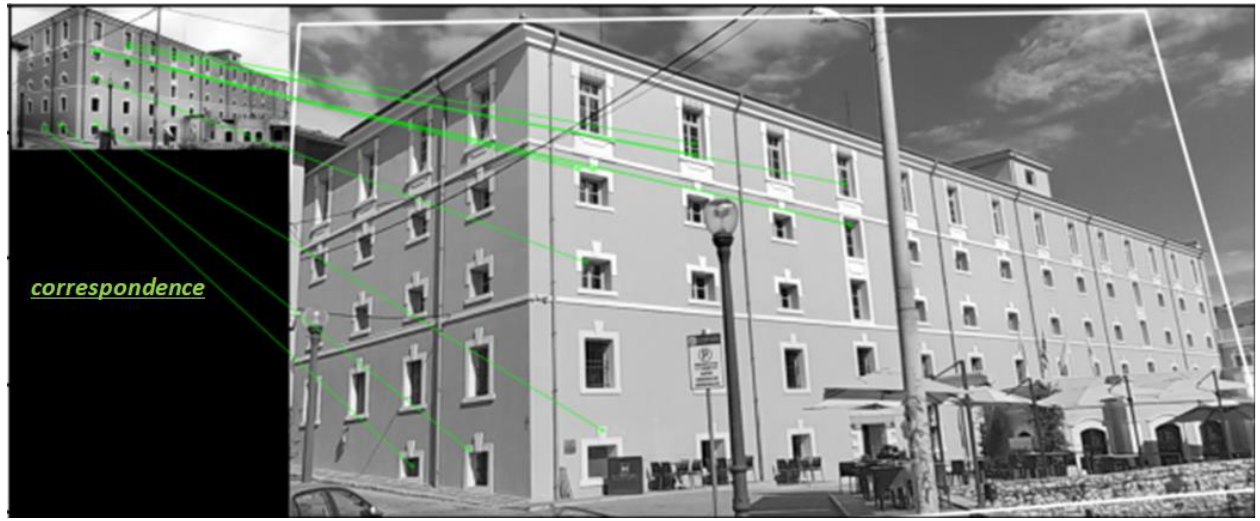
Figure 3. Feature detection and matching homologous points.